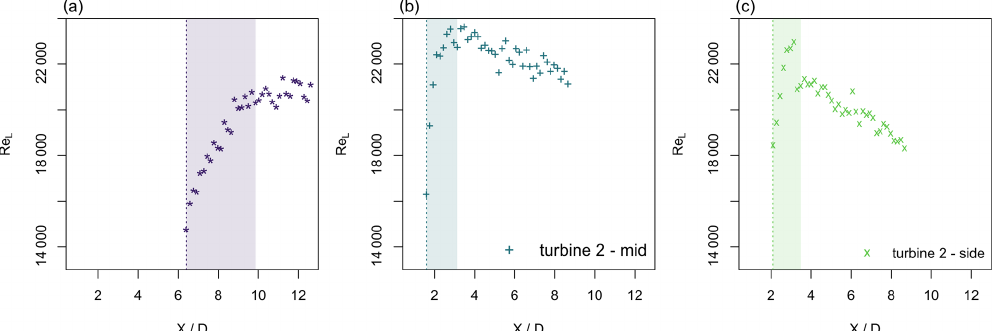
Figure 7. Downstream evolution of the local Reynolds number Re L for the three different inflow conditions at the centerline in the decay region of the TI: (a) turbine 1 – laminar inflow, (b) turbine 2 mid – turbulent, and (c) turbine 2 side – turbulent and intermittent. The vertical lines mark the maximum of the TI, and the colored area marks the region where the Taylor Reynolds number is